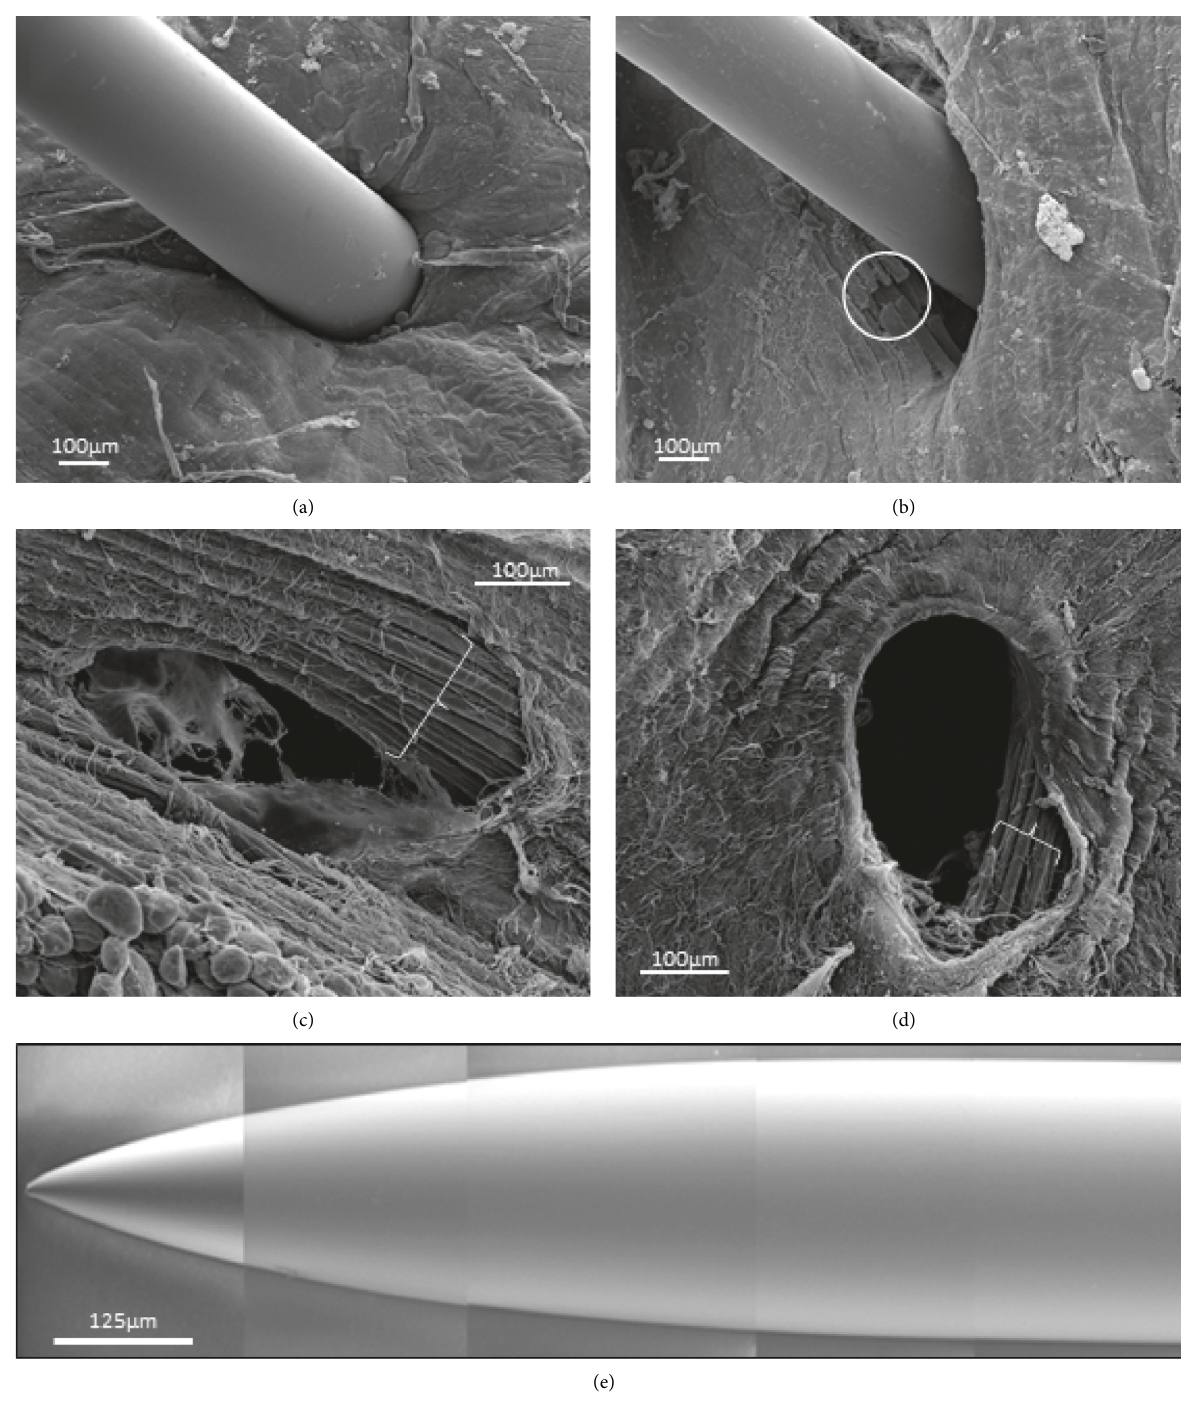
Figure 4: Scanning electron microscopy: examples of ex vivo dry needling in gastrocnemius muscle. The samples were processed without using collagenase. For this reason, the muscle fibers are mostly covered by endomysium and perimysium. This situation is especially evident in (a), where the needle punches the endomysium and perimysium. (b) A few injured muscle fibers are shown (white circle). Immediately below these, the fibers are unchanged. When the needle is removed, the muscle fibers return to its original position and the hole is almost closed (c), (d). Brackets, healthy muscle fibers. (e) Example of the tips of the needles used in